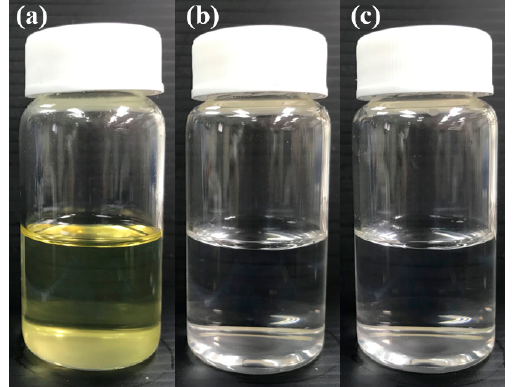
Figure 2. ( a ) SSM–SNEDDS appearance; SSM–SNEDDS dispersed in: ( b ) water; and ( c ) 0.1 N HCl at a ratio of 1:100 ( v / v ).